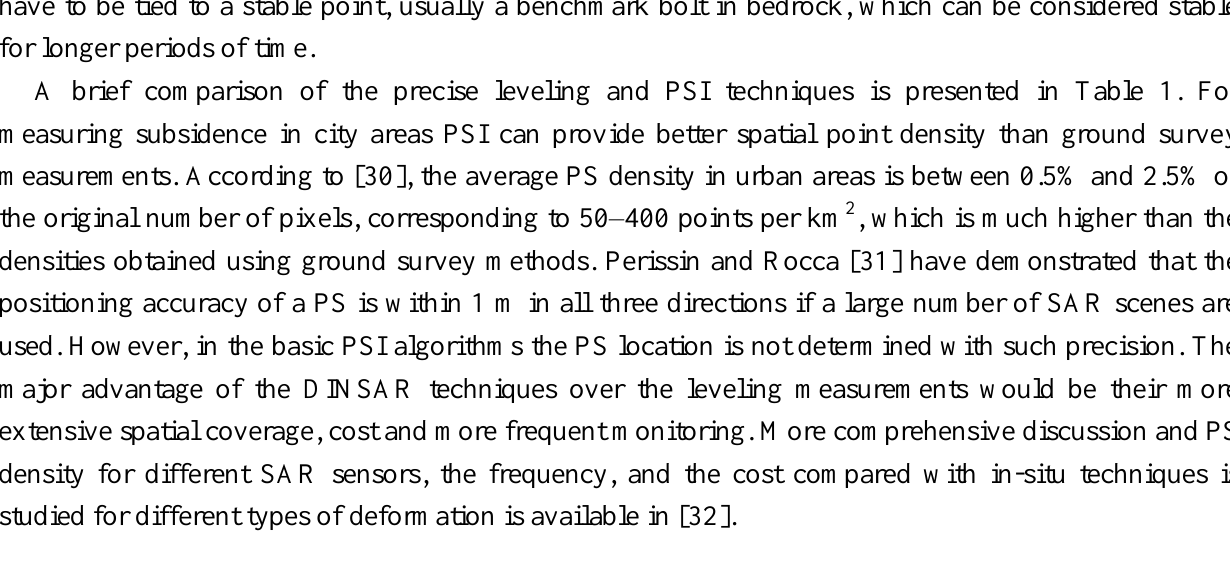
Table 1. A short comparison of precise leveling and persistent scatterer interferometry (PSI)